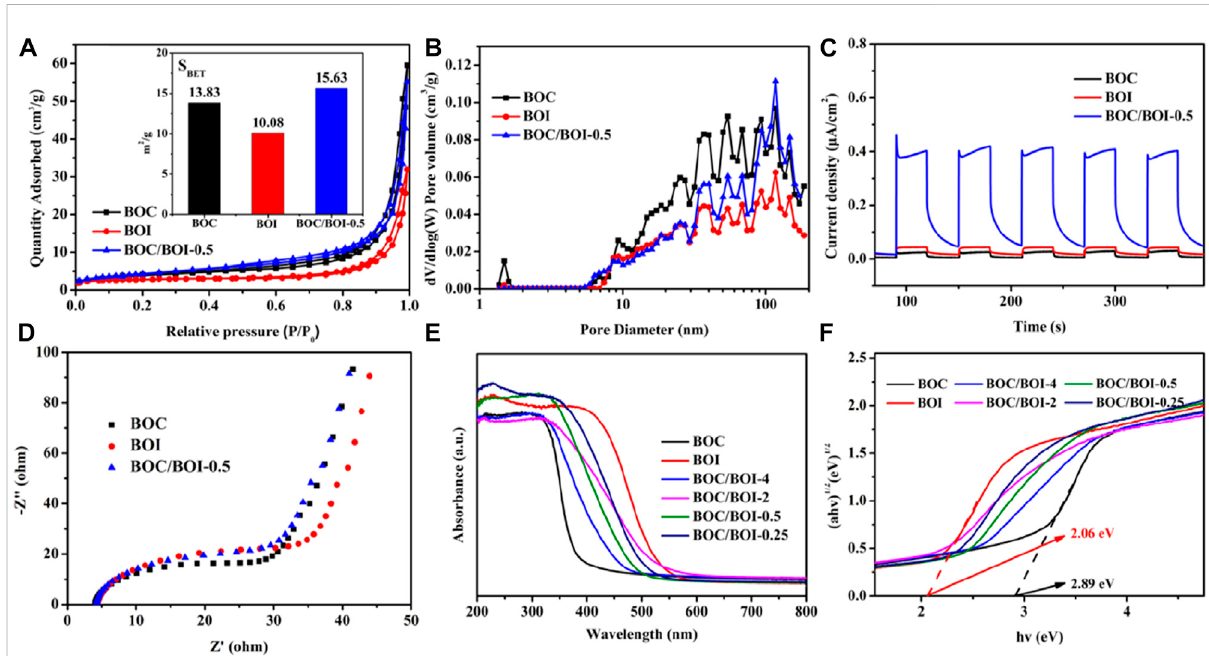
FIGURE 4 (A) Nitrogenadsorption isothermsand BETareas; (B) poresizedistributions; (C) photocurrent; (D) Electrochemicalimpedence spectra ofBOC, BOI and BOC/BOI-0.5; (E,F) UV-visible diffuse re fl ectance